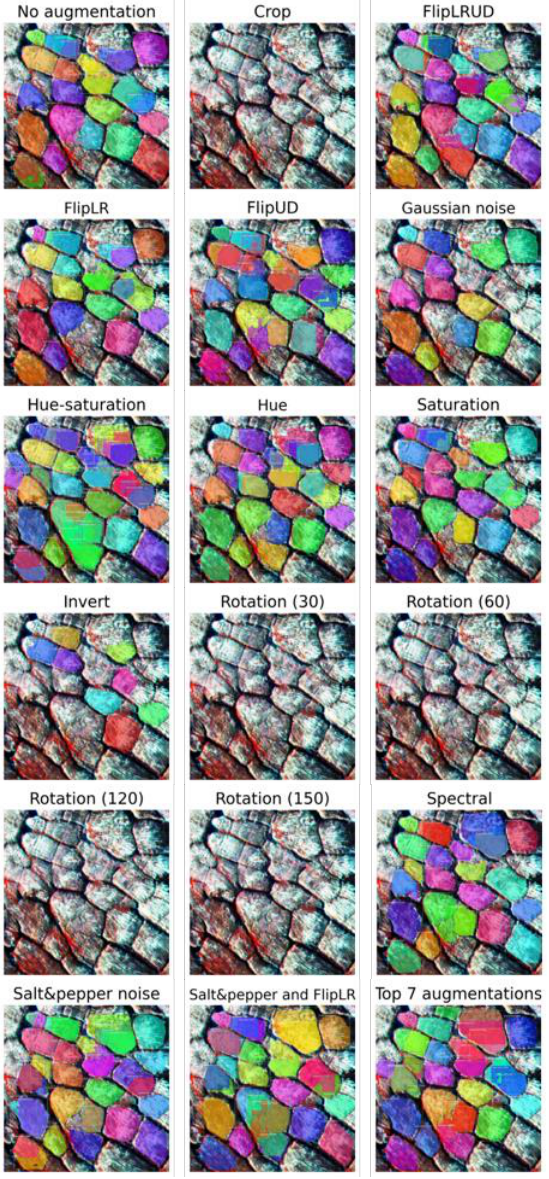
Figure 8. Sample outputs with different augmentation methods.